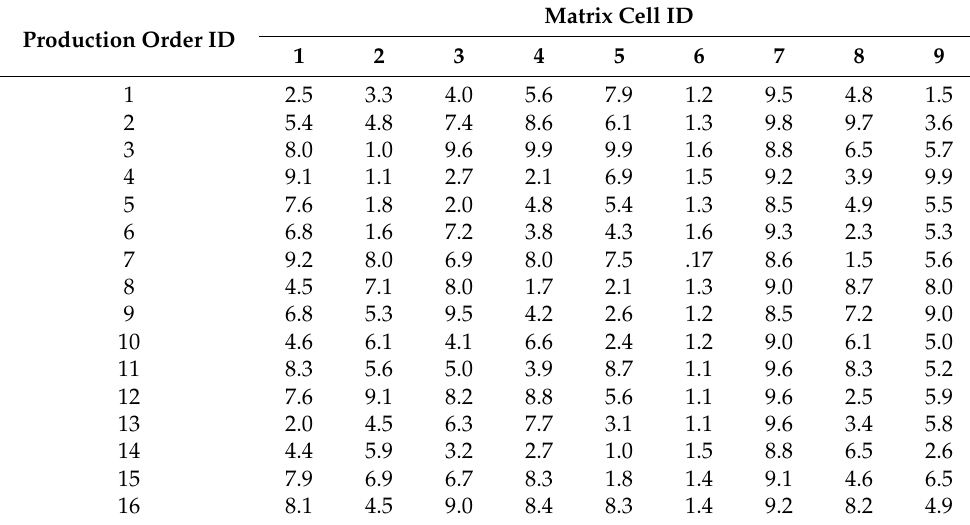
Table 2. Operation time of production orders [min].